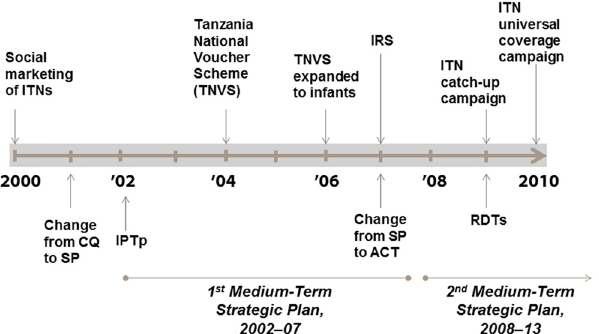
Fig 1. Timeline depicting years when national-level implementation of specific malaria control policies and interventions began in Mainland Tanzania, 2000 – 2010.